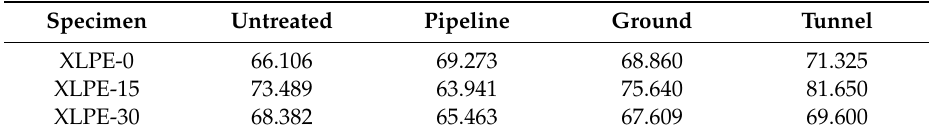
Table 7. Breakdown field strength (kV / mm).